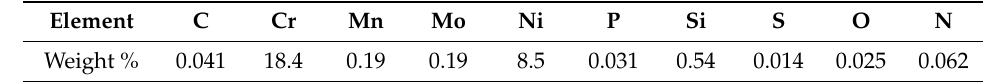
Table 2. Welding specification.